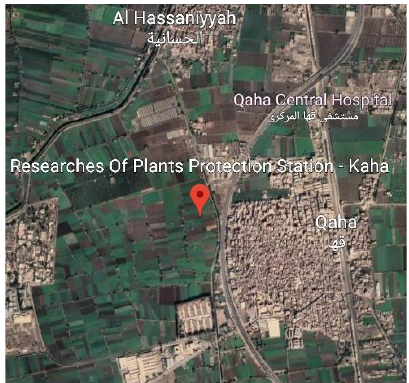
Figure 1. location of Research of Plant Protection Station, Qaha, Qalyubia, Egypt (30°17 ′ 01 ″ N, Figure 1. Location of Research of Plant Protection Station, Qaha, Qalyubia, Egypt (30 ◦ 17 (cid:48) 01” N, 31°12 ′ 02 ″ E). 31 ◦ 12 (cid:48) 02”